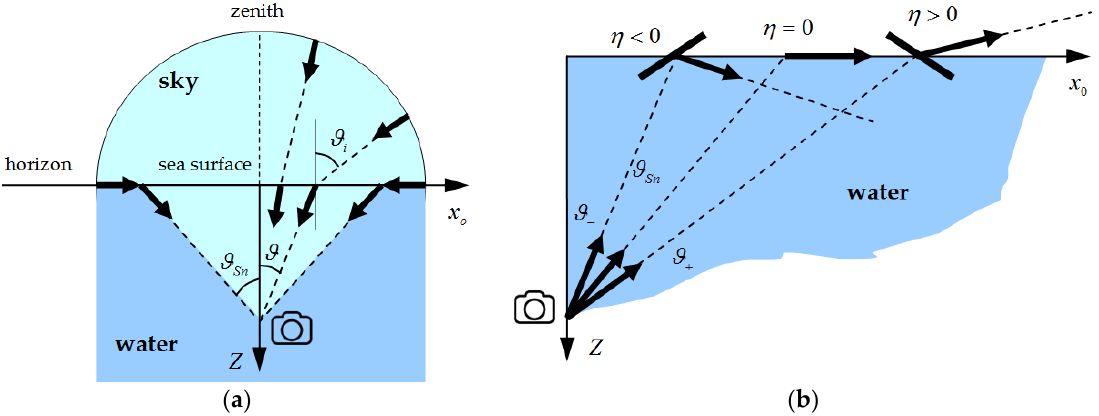
Figure 2. Graphical explanation of ( a ) the Snell ’ s window for a flat sea surface and ( b ) occurrence of spot structure near its border due to surface waves.